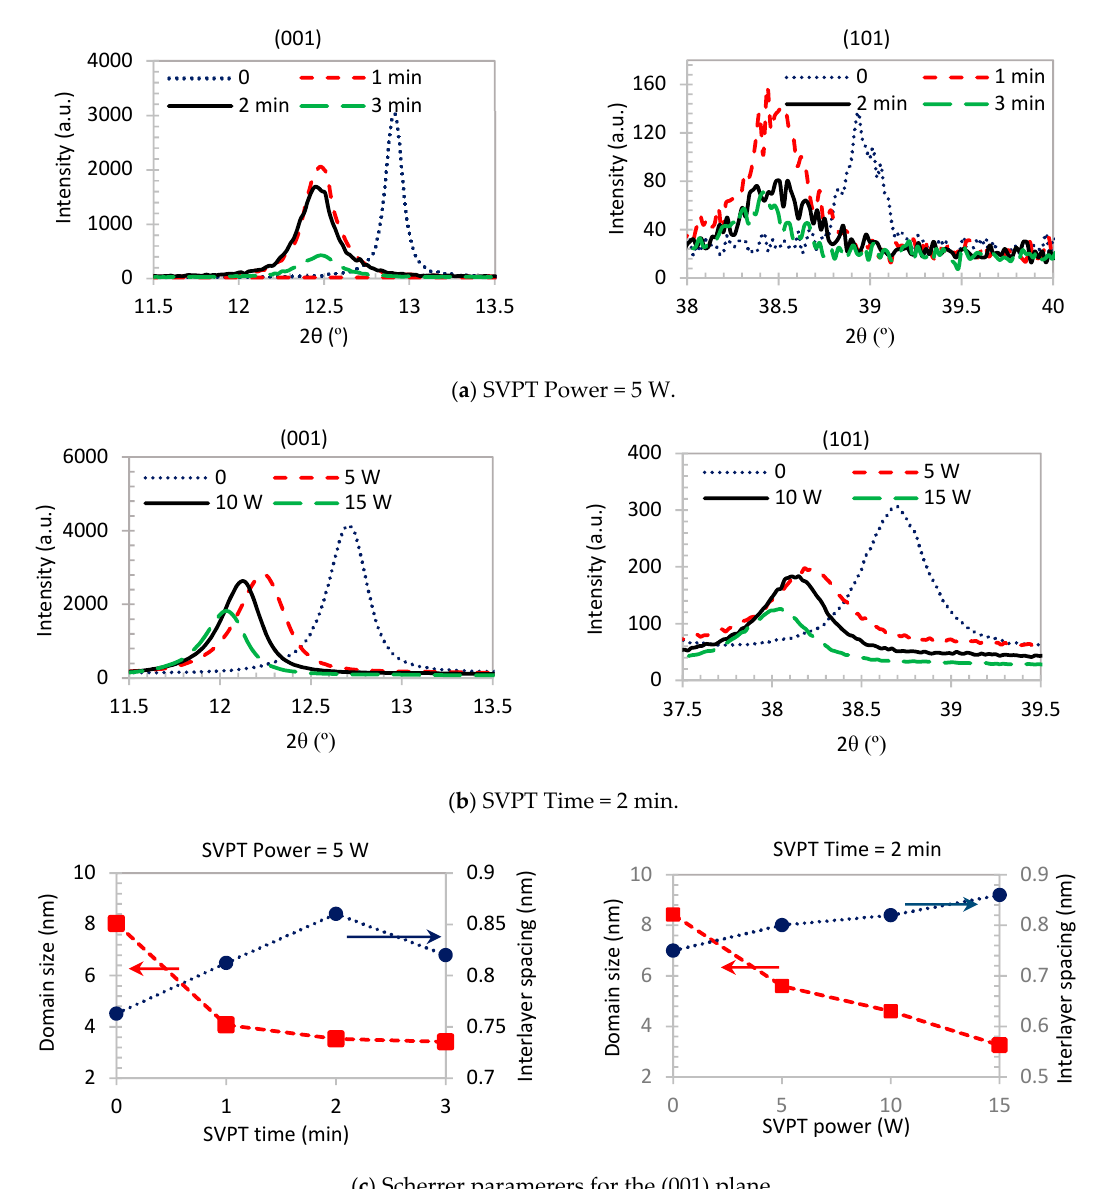
Figure 6. Effect of the SVPT on XRD peaks of the PbI 2 thin films. ( a ) Effect of the vibration time at a fixed vibration power of 5 W; ( b ) the effect of the vibration power on samples subjected to a 2 min SVPT; and ( c ) crystal domain size and interlayer spacing of two samples; the left diagram shows the samples prepared at varying vibration time at a constant power of 5 W, and the right diagram shows the samples prepared at varying ultrasonic power applied for 2 min.